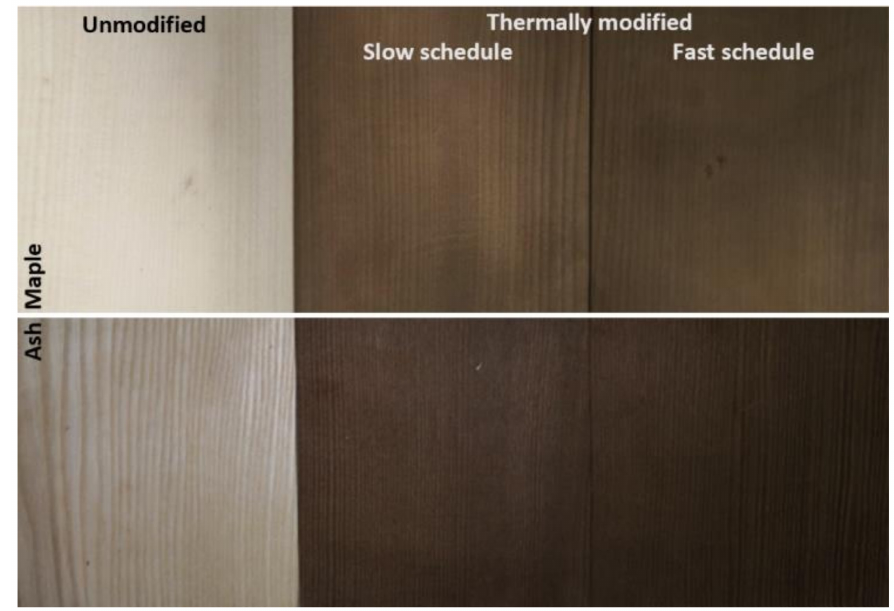
Figure 4. Unmodified and thermally modified maple and ash